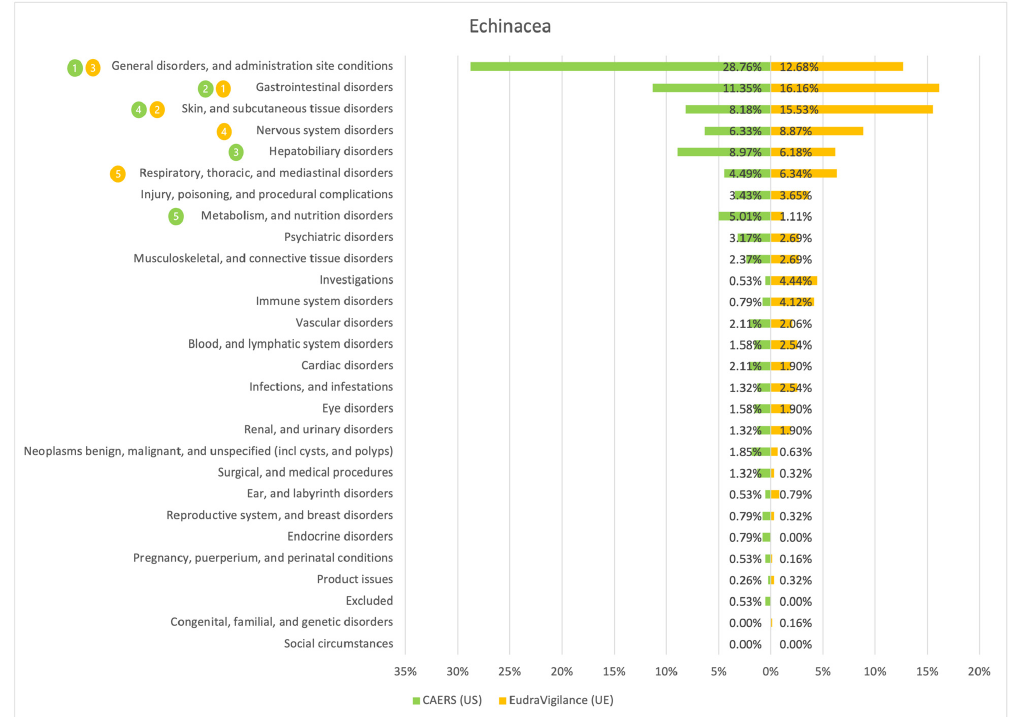
Figure 5. Summary of the frequency of reporting side effects of Echinacea in the US and EU registers. Data marked in green refer to the CAERS (US) database and yellow to the EudraVigilance (UE) database. Numbers 1–5 present the most commonly reported categories of adverse effects in descending order.